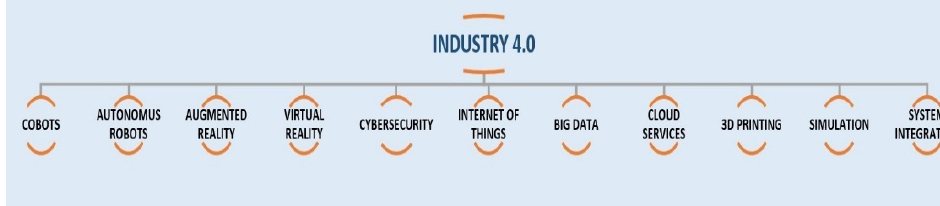
Figure 1. Industry 4.0 ecosystem.